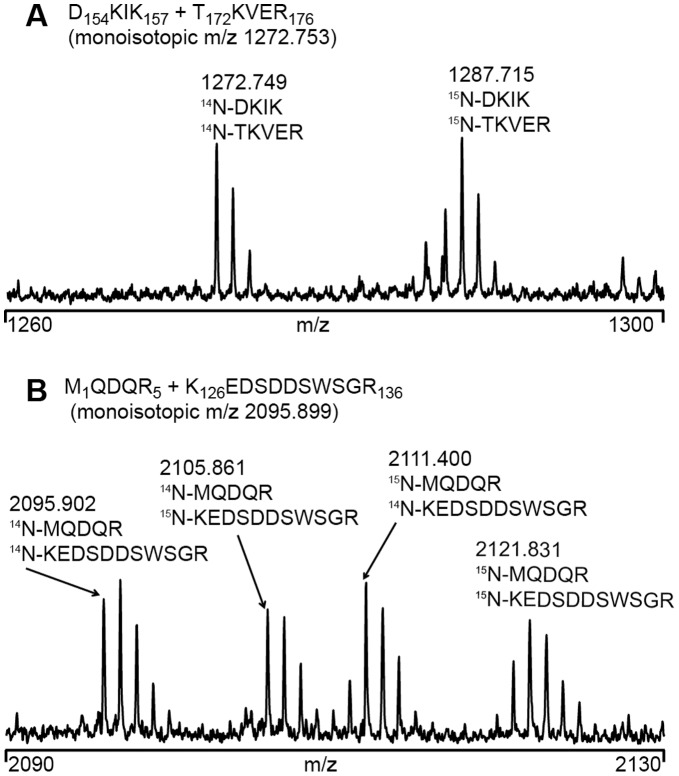
Crosslinks detected by FINDX map into the protein structure.Crosslinks detected by FINDX and validated by MSMS are listed in Table 1 and here mapped into the structure of the Hsp21 protein between the Cα atoms of two lysines. Assuming a maximum distance between the two Cα atoms of crosslinkable lysines of 20 Å (12+8 Å  =  length of the BS3 crosslinker and 2 x the lysine side chain), all identified intra-dimeric crosslinks are reconcilable with the dimer structure. The Hsp21 protein is composed of six dimers [16] but for clarity only one dimer is presented with subunit A (to the left, dark grey) and subunit B (to the right, lighter grey). Two crosslinks that are inter-monomeric involve the lysine residue K126, which is located in the flexible loop with strand β6, that stabilizes the dimers via strand exchange between the two monomers [24]. The image of the Hsp21 structure model [19] was prepared with PyMOL (http://www.pymol.org).